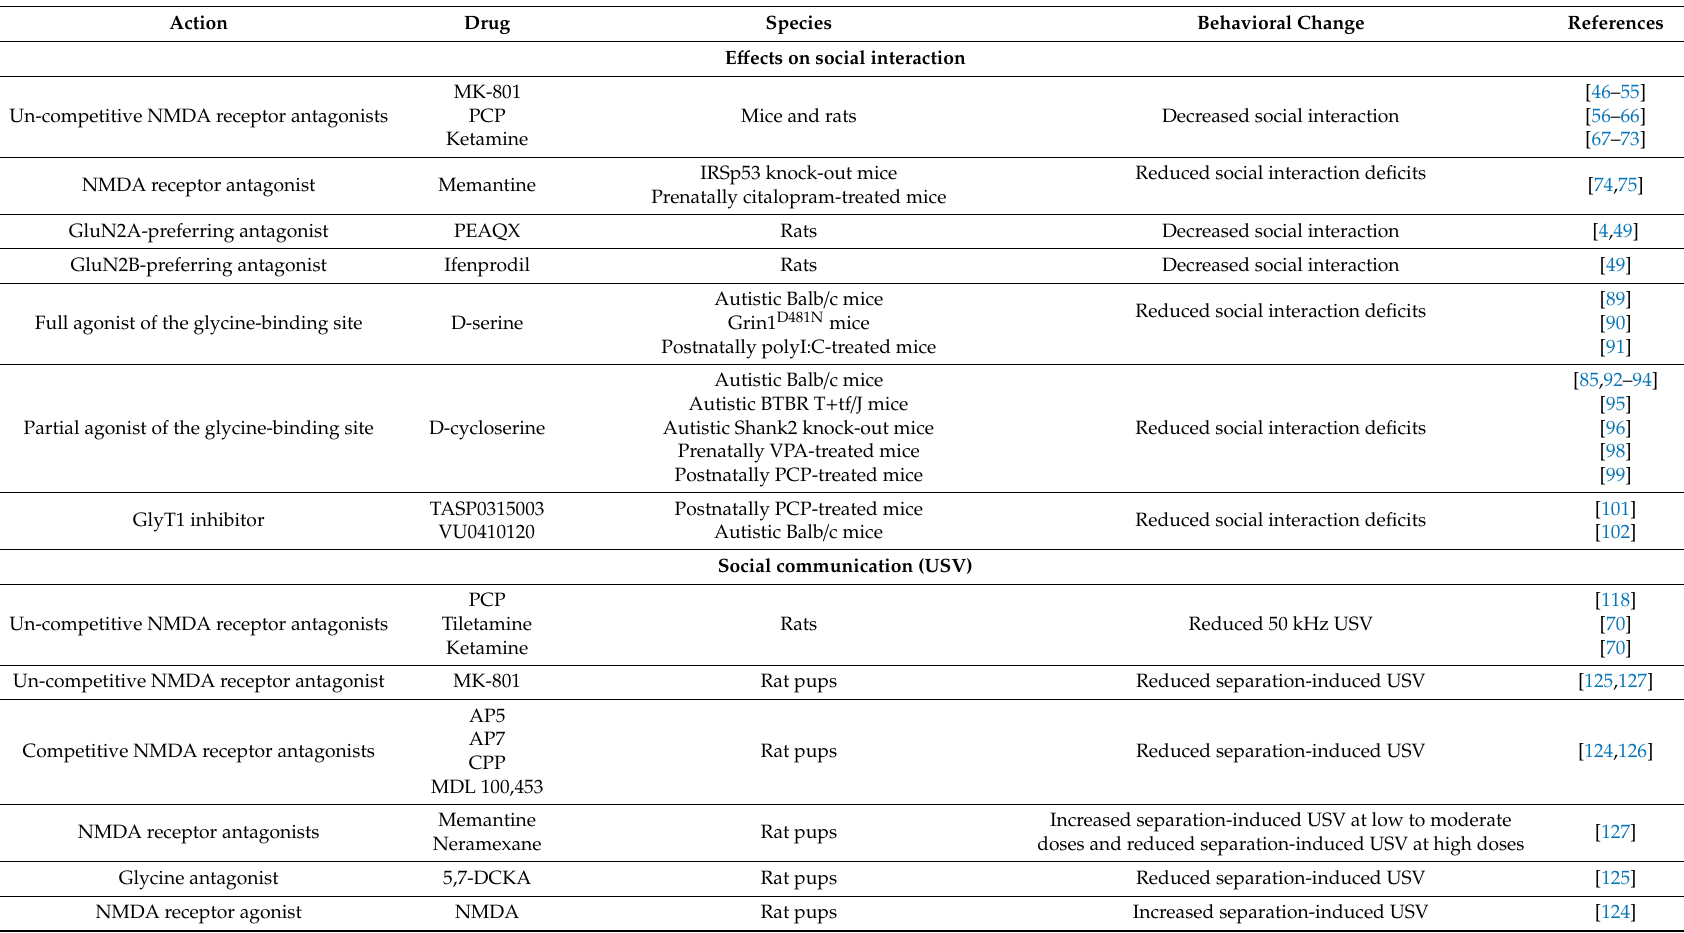
Table 2. E ff ects of the NMDA receptor agonists and antagonists on social behavior in